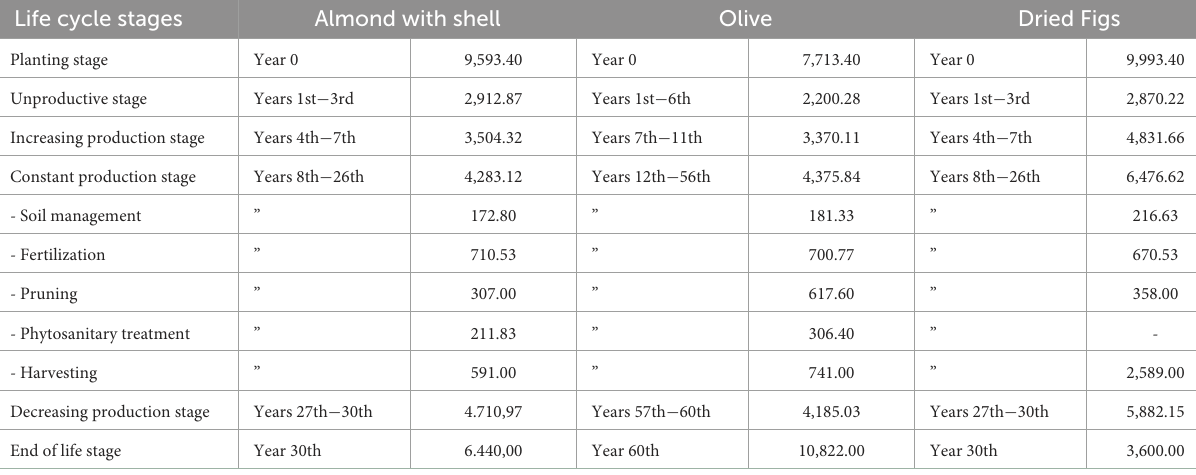
Life cycle stages Almond with shell Olive